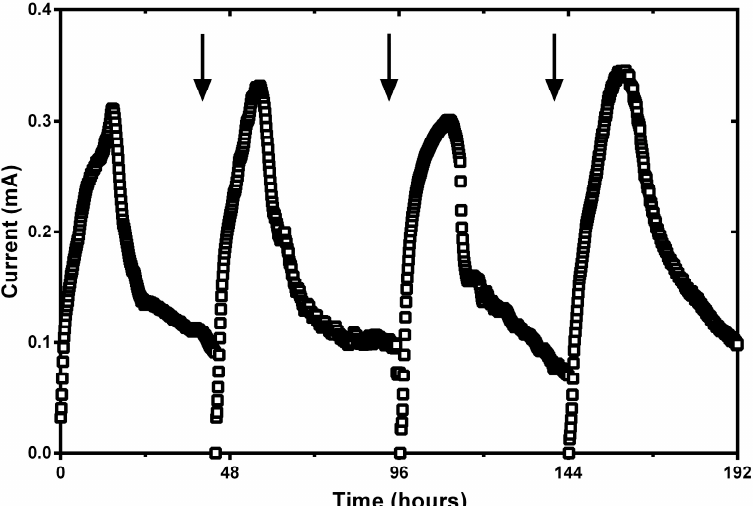
Figure A1. Current generation during batch operation. Typical shape is observed for the current behavior, which reaches a peak and then descend gradually over every cycle. Culture medium replenishments (1.3 g ∙ L − 1 Pyruvate, pH = 3.7 ± 0.1) are shown by the arrows. The data set shows four current cycles representative of the entire operation period.